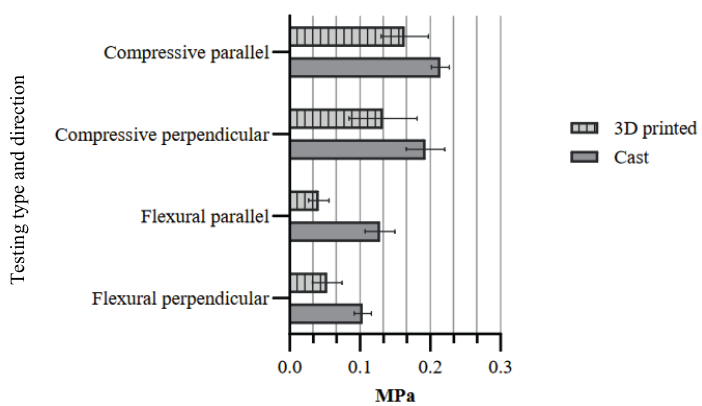
Fig. 2. Compressive and flexural strength for cast and 3D printed samples in both